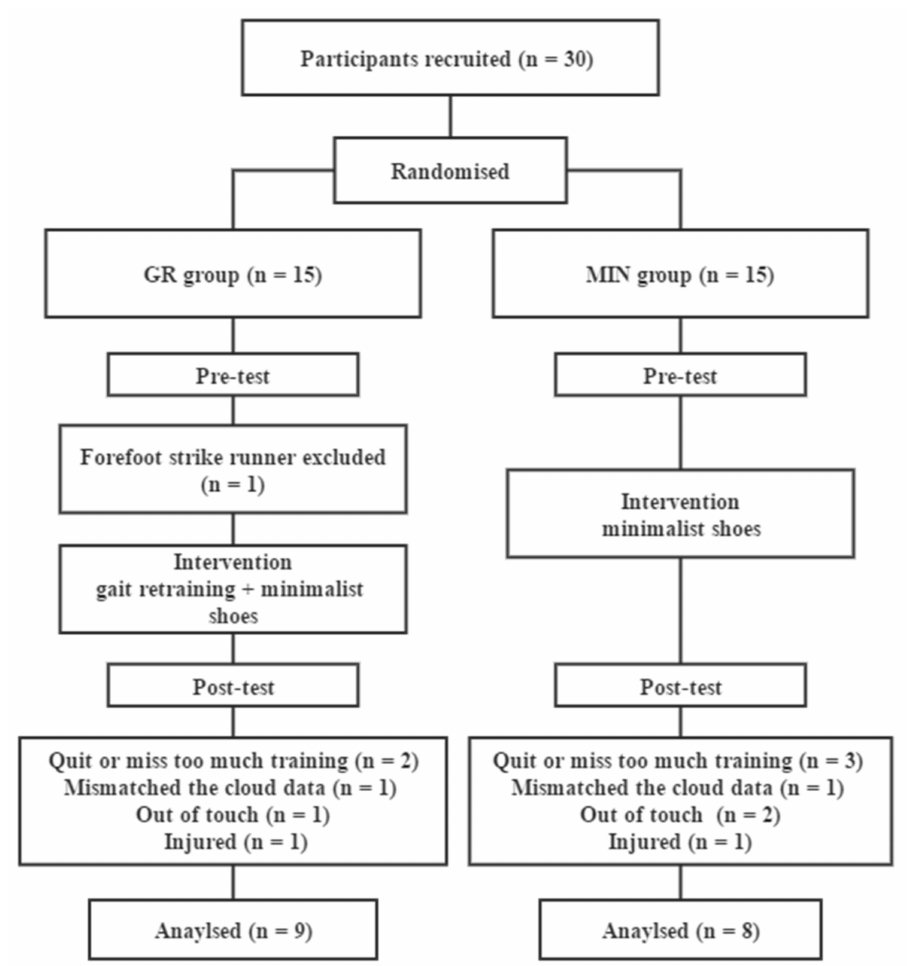
Figure 1. Flow diagram of this